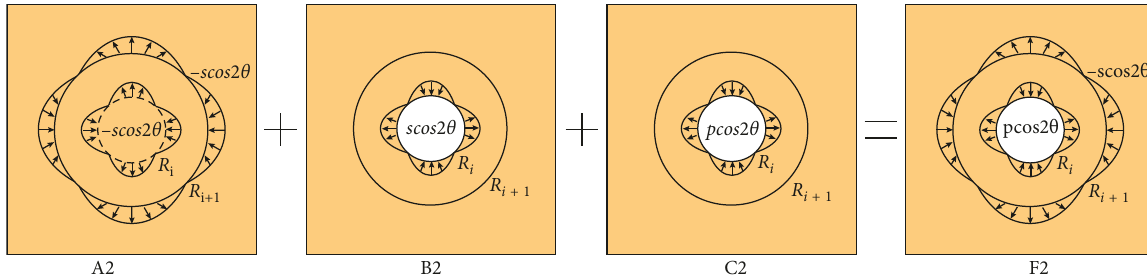
Figure 10: Formation stress components under the nonuniform stress